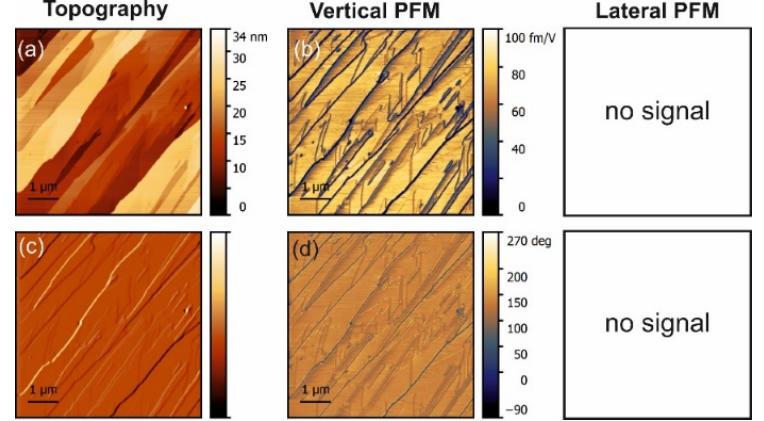
Figure 1. PFM measurements in undoped glycine. ( a ) Topography and ( c ) deflection; ( b ) amplitude and ( d ) phase of the vertical piezoresponse. The lateral PFM was null because no resonance could be excited.